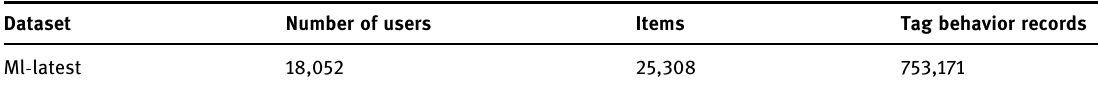
Table 1: Experimental data set Movielens